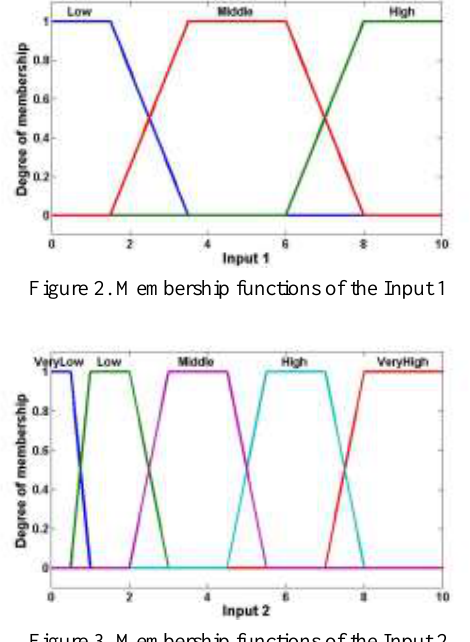
Figure 8. Membership functions of the Input